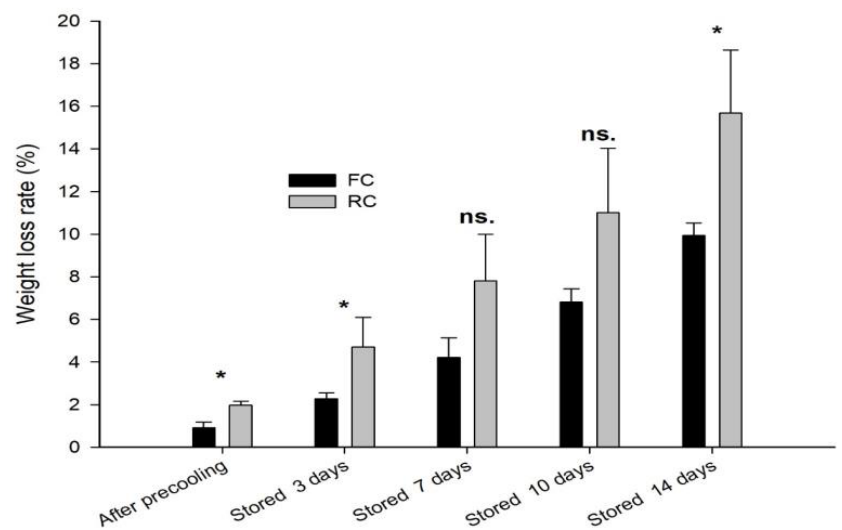
Figure 2. Effects of FC and RC on the weight loss rate during the storage of winged bean pods. * Significant difference between the two treatments according to the least significant difference test ( p < 0.05). ns.—non-significant difference between the two groups. Data are expressed as mean ± SD of five replicates ( n = 5). Table 2. Effects of FC and RC on changes in pod color during the storage of winged bean pods. Storage at 12 ◦ C